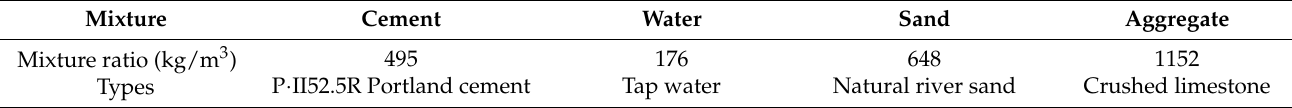
Table 1. Mixture ratio and type of concrete.